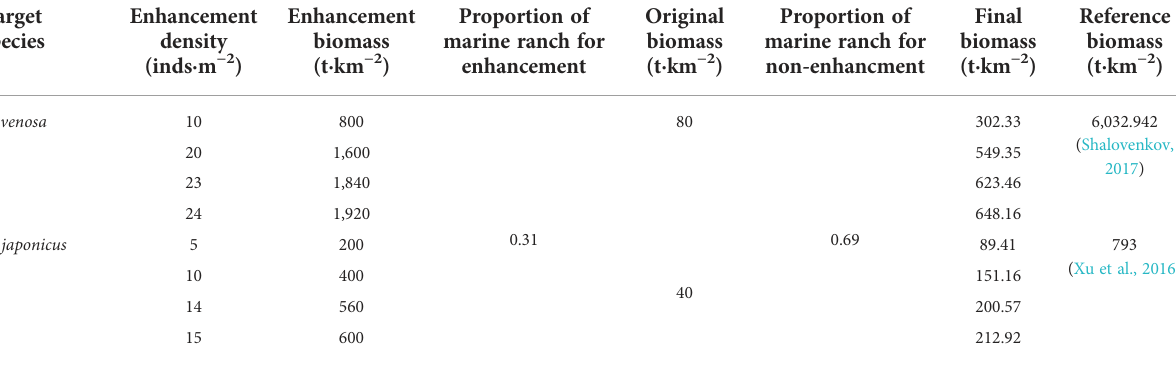
TABLE 2 Simulation scenarios for different enhancement densities of the target species, red snail Rapana venosa and sea cucumber Apostichopus japonicus , in Laizhou Bay marine ranching using the Ecopath with Ecosim model. Target